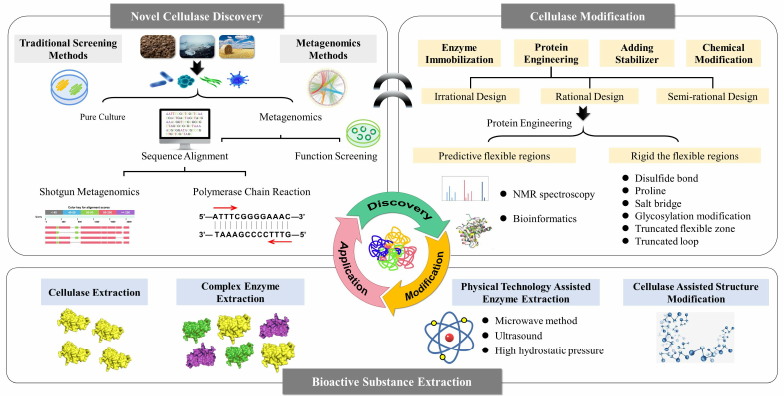
Figure 1 Figure 1. Strategies for obtaining high-performance cellulase and its application in natural medicine